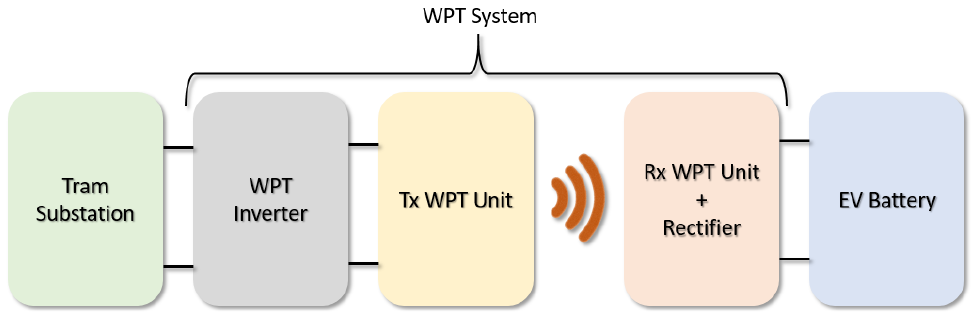
Figure 1. Schematization of the final EV battery charging application for the WPT system under